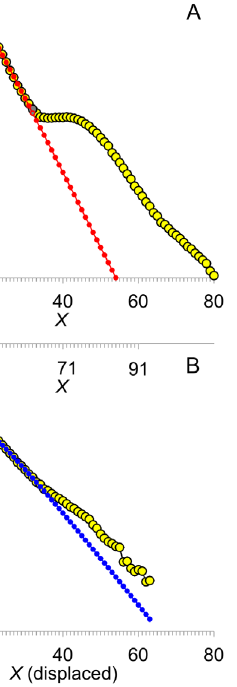
Figure 3. Components of the CLD, given in Figure 2 , fitted with the model. (A) Fitting (red filled circles) to single-lamella (SL) chains with the substrate-competing model. X =32 marks the apparent length of chain needed for the chains to enter the contiguous amorphous lamella (Figure 5). Where the slope changes significantly in Feature F gives the range of presumed three-lamellae-spanning chains. (B) Fitting (blue filled circles) to the type-2 TL chains with the substarte-competing model, which is the difference between the experimental and the calculated SL CLD in (A) and displaced (details in the Model section). The actual X is shown on the upper abscissa of